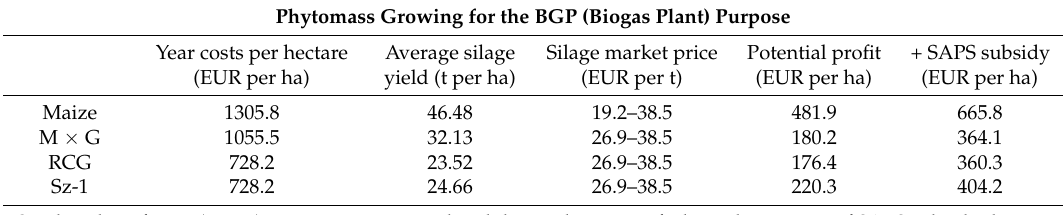
Table 20. Model economic balance based on the market